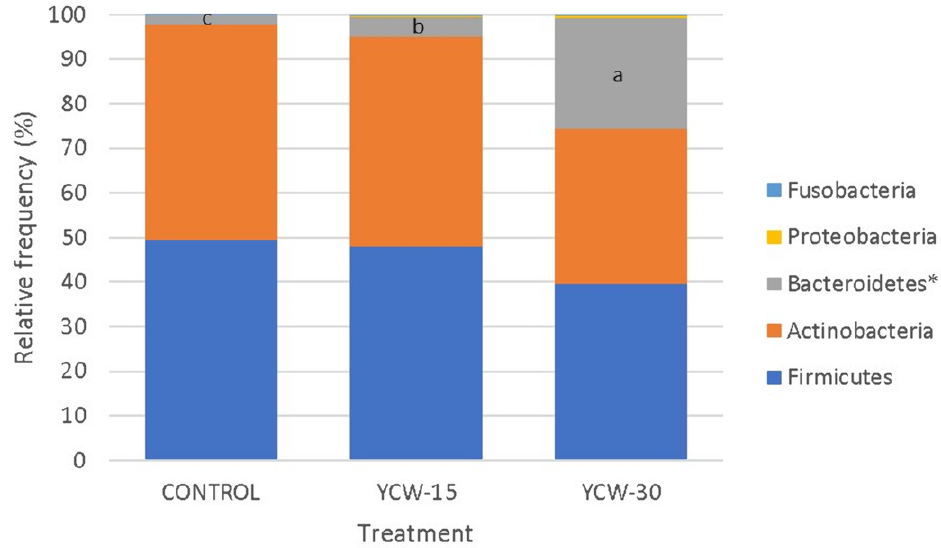
Figure 3. Relative frequency variation of the main fecal bacterial phyla in control, YCW-15, and YCW-30 groups. a,b,c Boxes with the same letters are similar at p ≤ 0.003. * Phylum with significant differences.